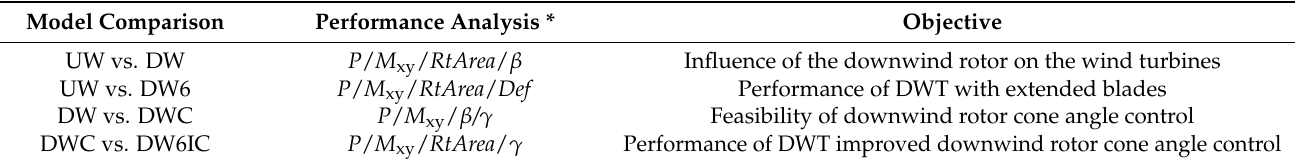
Table 3. Pairwise comparison of these five simulation